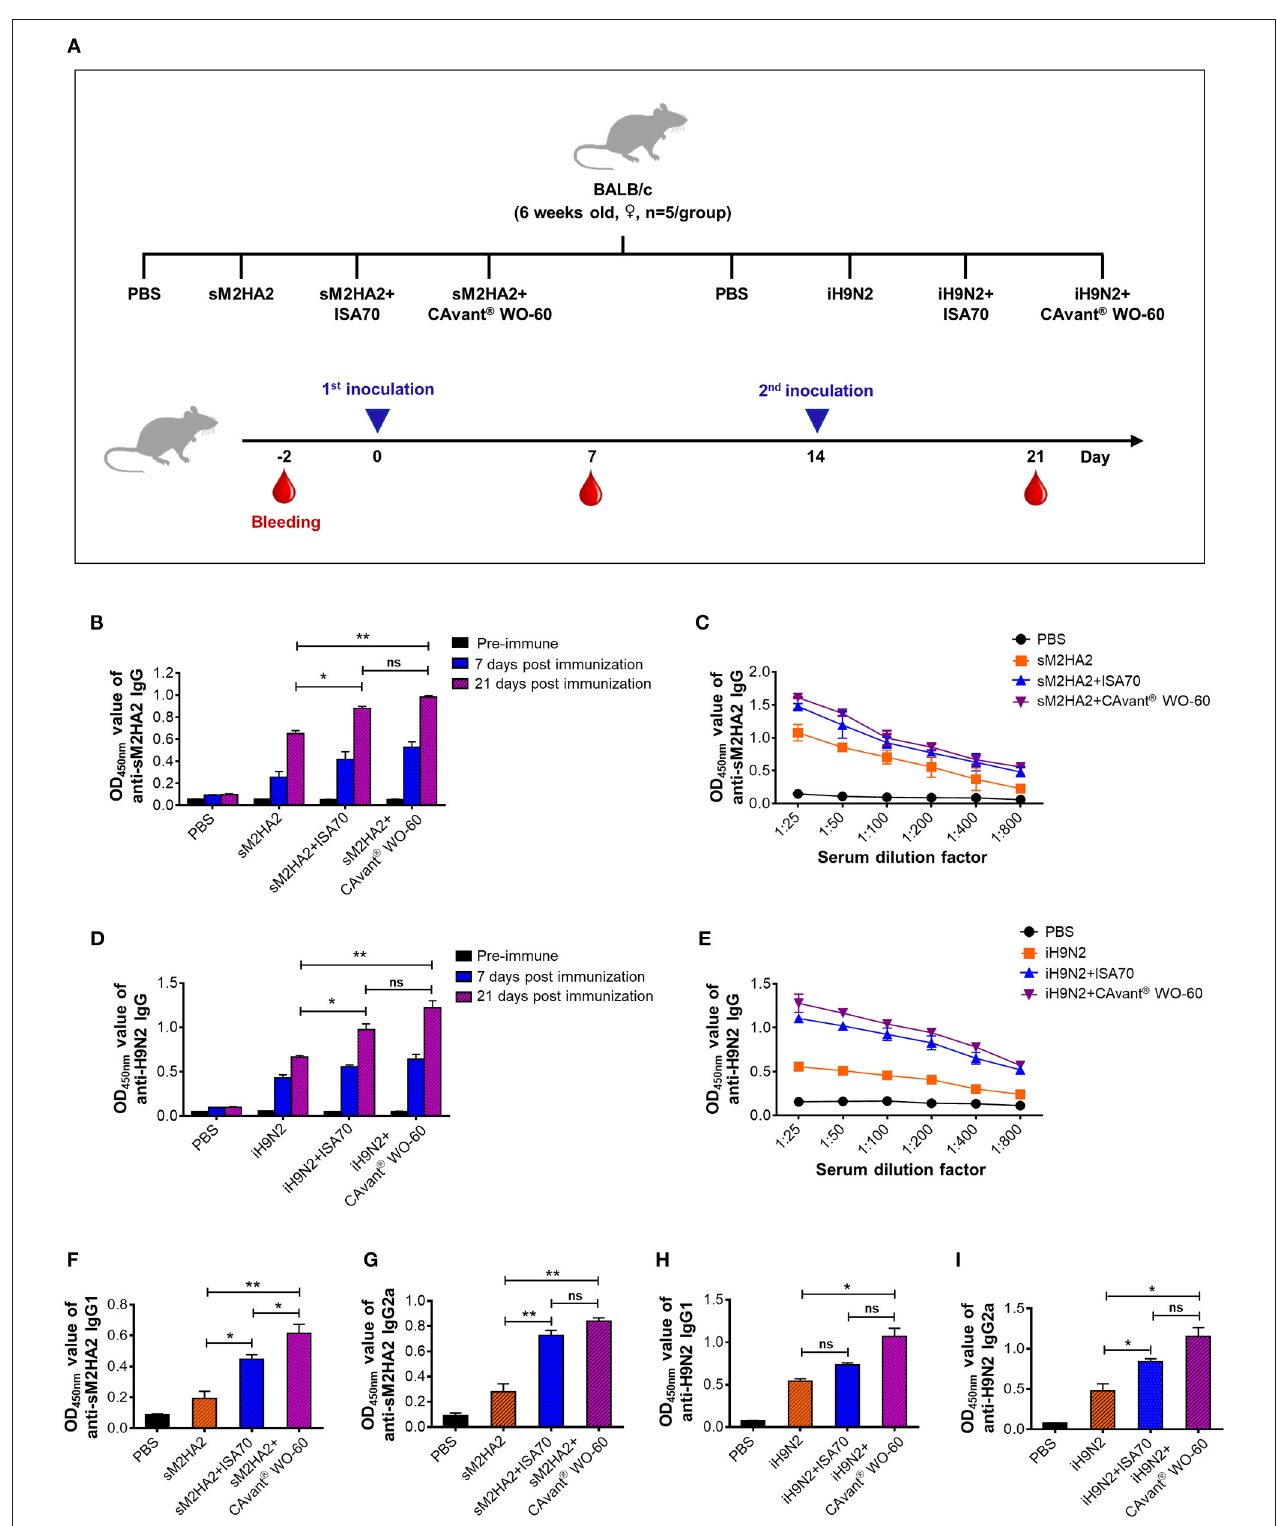
FIGURE 1 | Evaluation of the antigen-specific humoral immune response in mice. (A) Schematic depiction of mice experiment strategy. Mice were intramuscularly administered twice every other week. Serum samples were collected on day − 2 (pre-serum), day 7, and day 21 after first immunization. The antibody response